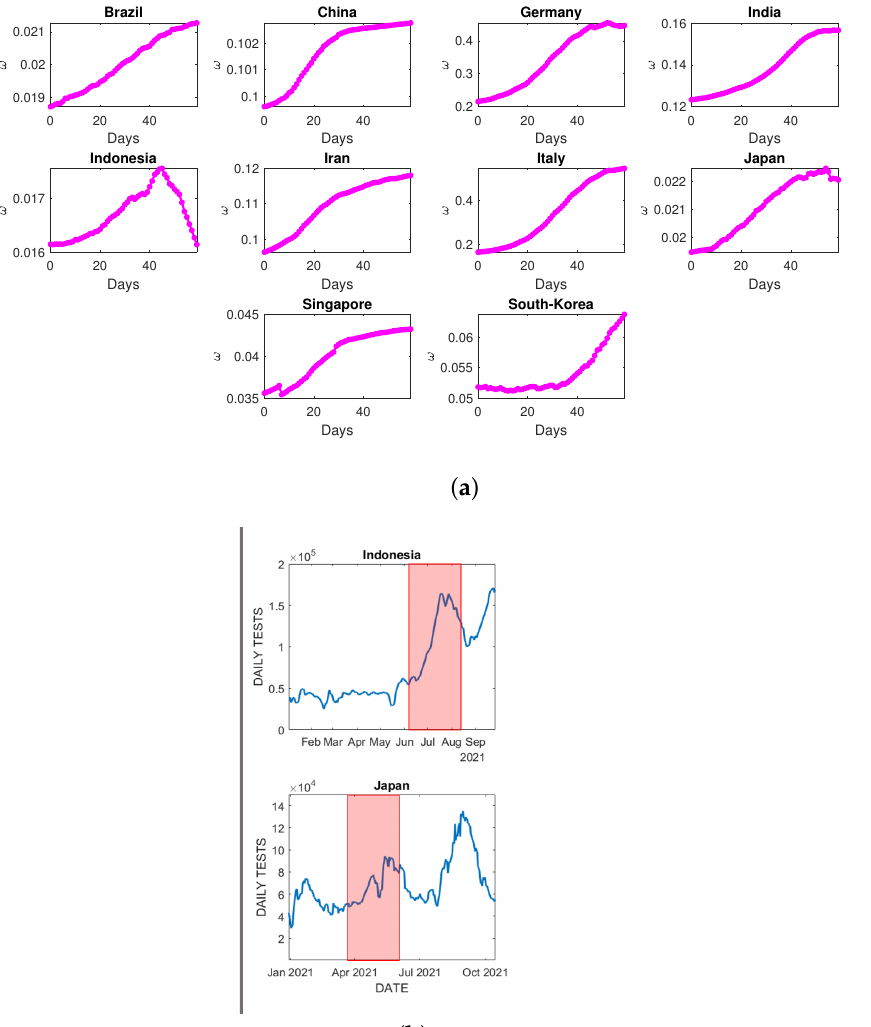
Figure 11. ( a ) Dynamics of estimated ω ( t ) , 60 days after the initial second wave emerged; ( b ) the daily test experienced a significant drop in Indonesia and Japan during the simulation interval (in the red-shaded